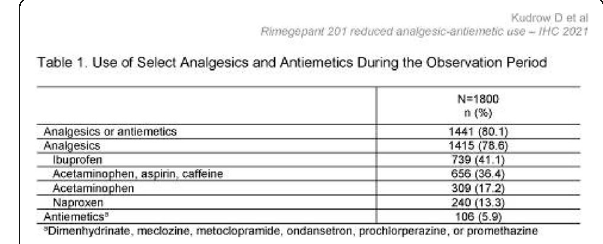
Table 1 (abstract P0271). See text for description